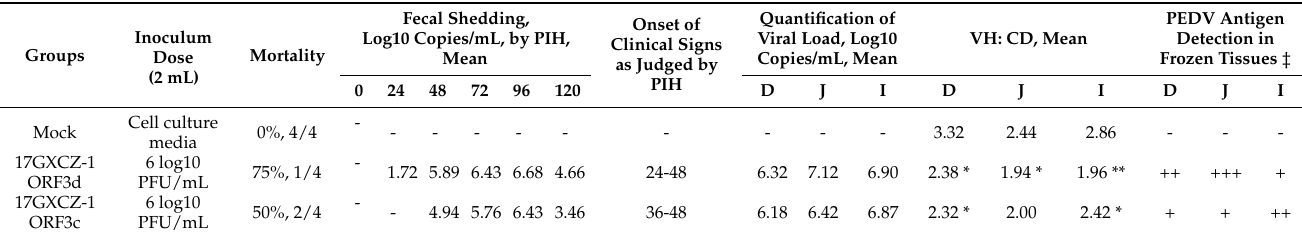
† PEDV, porcine epidemic diarrhea virus; PIH, post inoculation hour; VH:CD, ratio of villous height to crypt depth; D-duodenum, J-jejunum, I-ileum; PFU, plaque formation unit; -, no result. ‡ PEDV antigen detection in frozen tissues. +, ++, and +++ denotes less than 30%, 30–60% and more than 60% of villous enterocytes showing a PEDV antigen positive signal, respectively. Viral load in the fecal wastes and in the tissues of the small intestine was detected by RT-quantitative PCR (RT-qPCR). * and ** represent significant differences when compared to the mock group, with p values of <0.05 and <0.01,